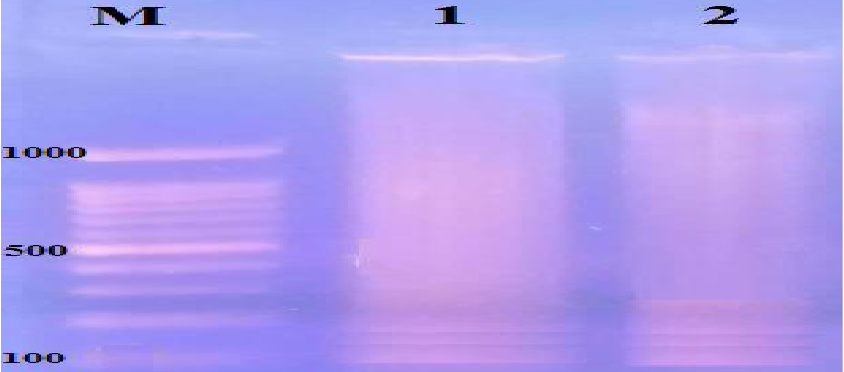
Figure 2. Agarose gel electrophoresis of LAMP amplified alpha-INT1 gene of fluconazole sensitive (1) and fluconazole resistant (2) C. albicans (The positive reaction is manifested as a ladder-like pattern on the 1.5% agarose gel due to the mechanism of LAMP reaction as a loop amplifier that uses at least 4 primers) . M is 100 bp DNA ladder marker